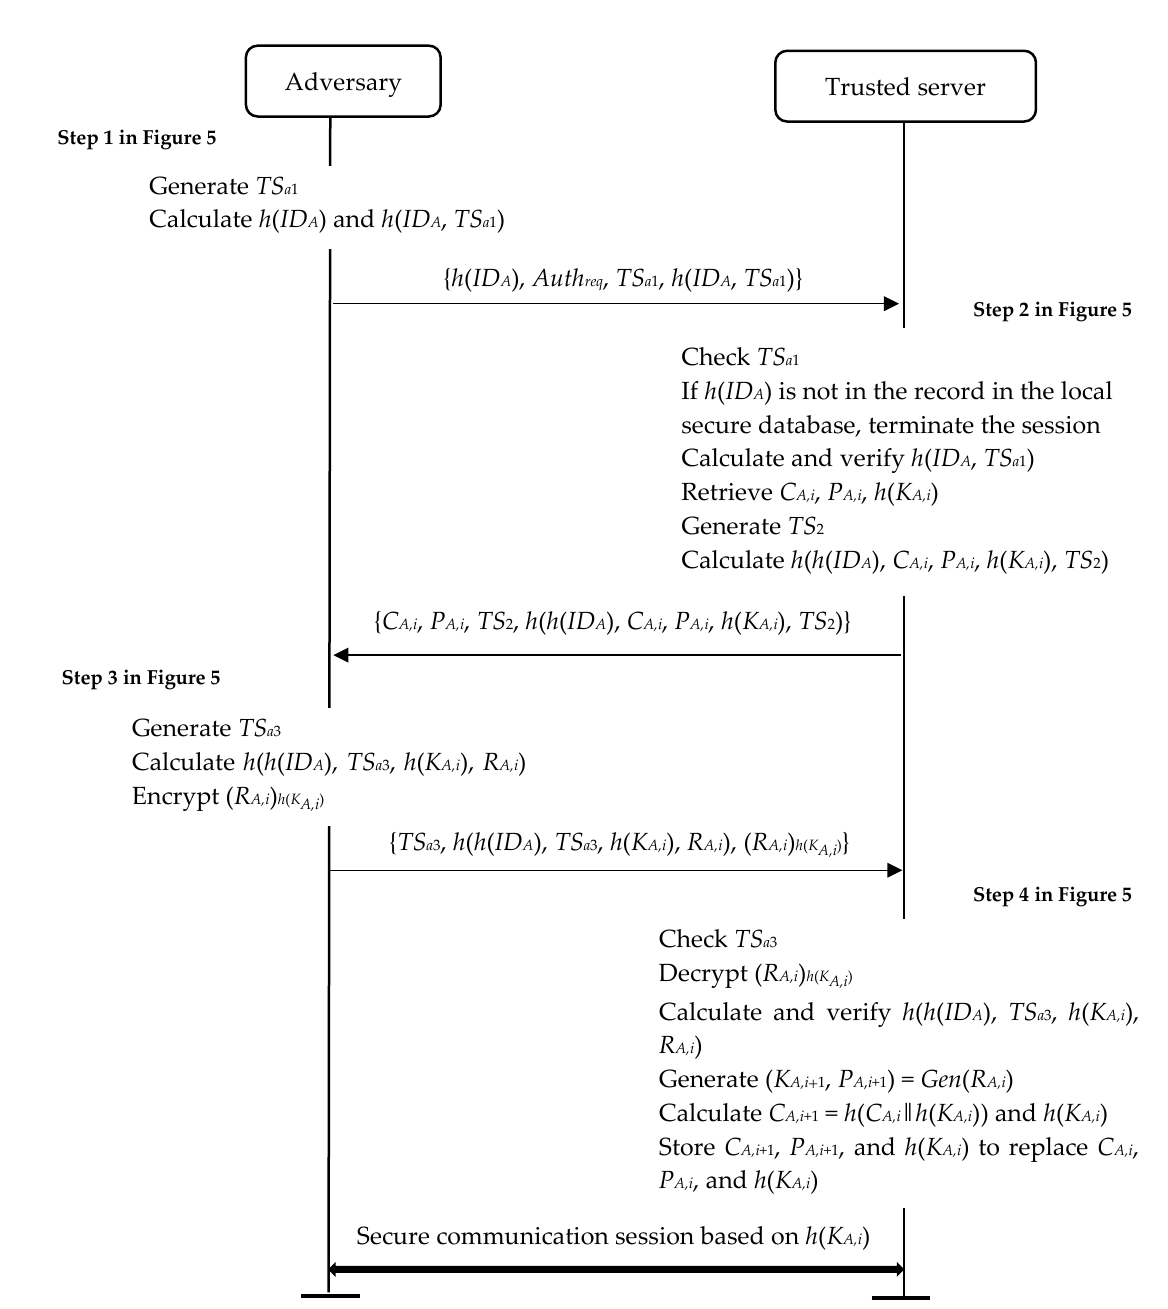
Figure 7. Impersonating IoT device